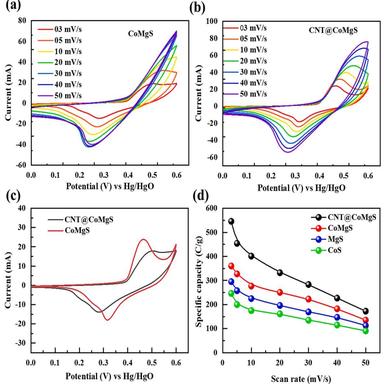
(a, b) CV curves with potential window 0.6 V at different scan rates (3–50 mV/s) of CoMgS and CNT@CoMgS, (c) Shows the comparison of CV measurements at 3 mV/s, (d) Comparison of computed specific capacity values of CoS, MgS, CoMgS, and CNT@CoMgS.